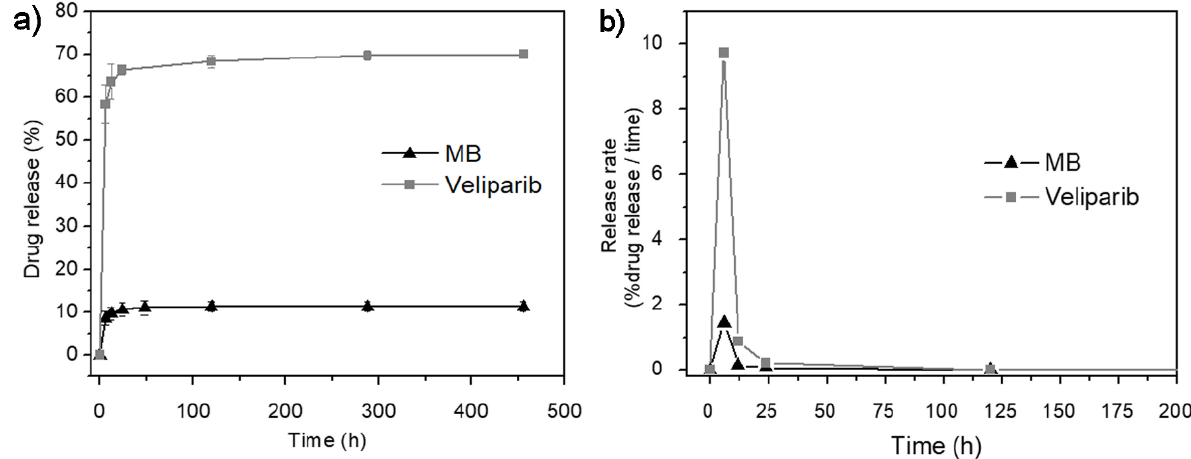
Figure 5. ( a ) Drug release profile of MB and veliparib from VMB-NPs. ( b ) Release rate of MB and veliparib from VMB-NPs as a function of time.